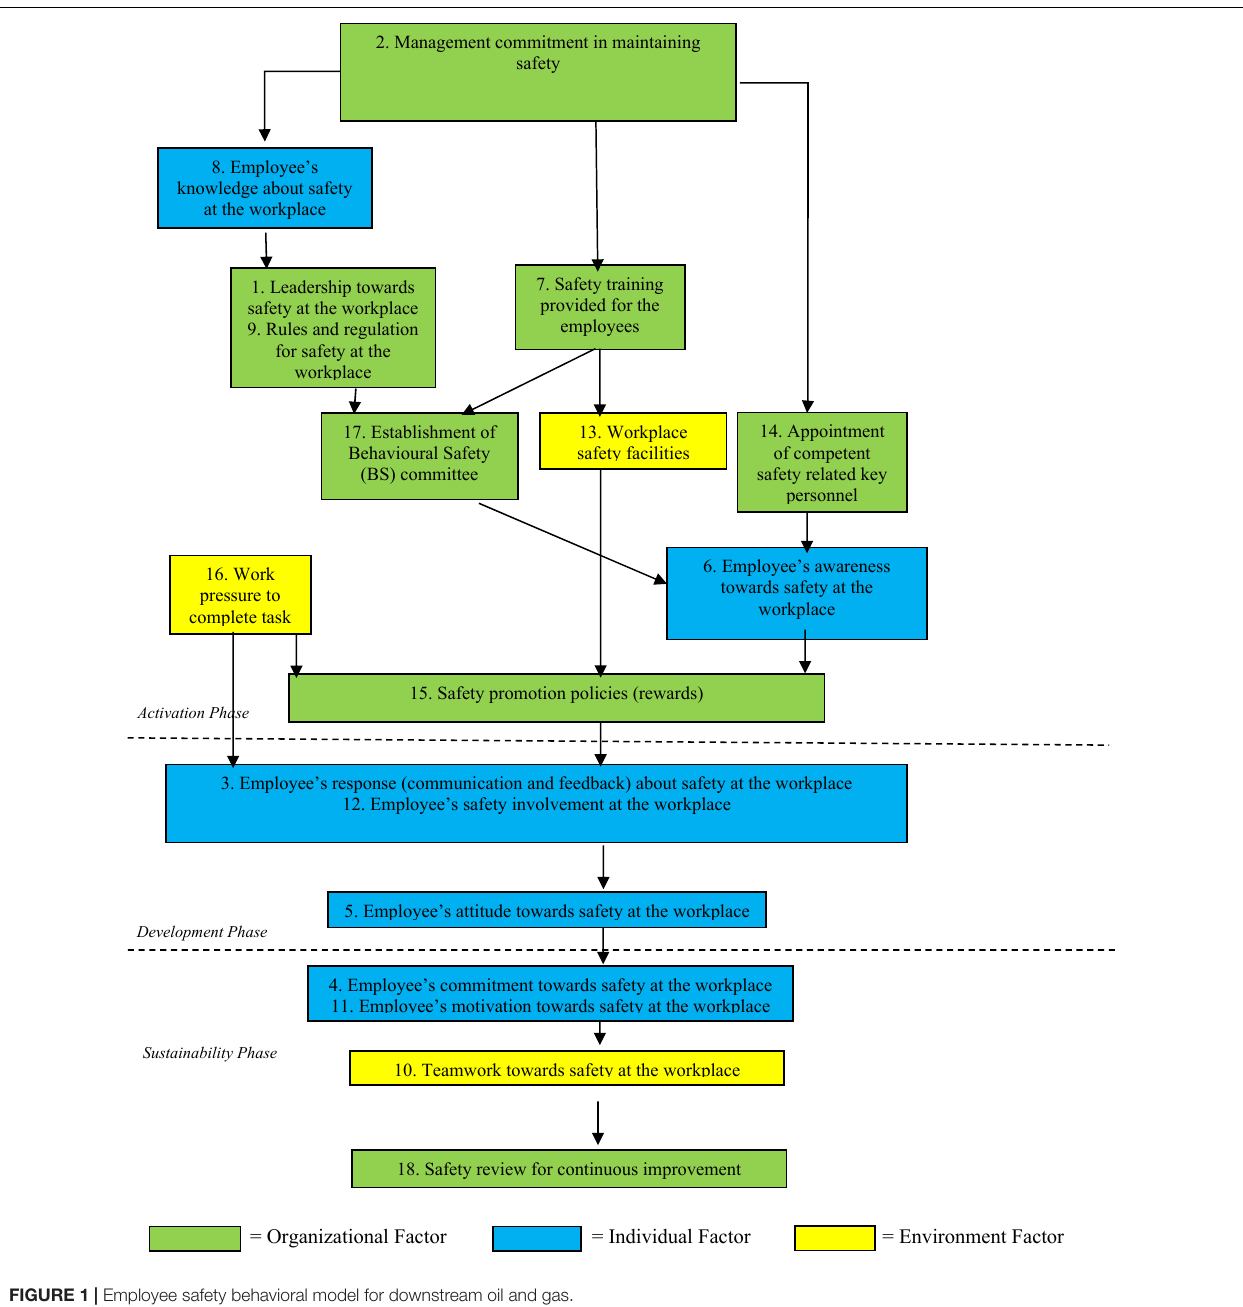
FIGURE 1 | Employee safety behavioral model for downstream oil and